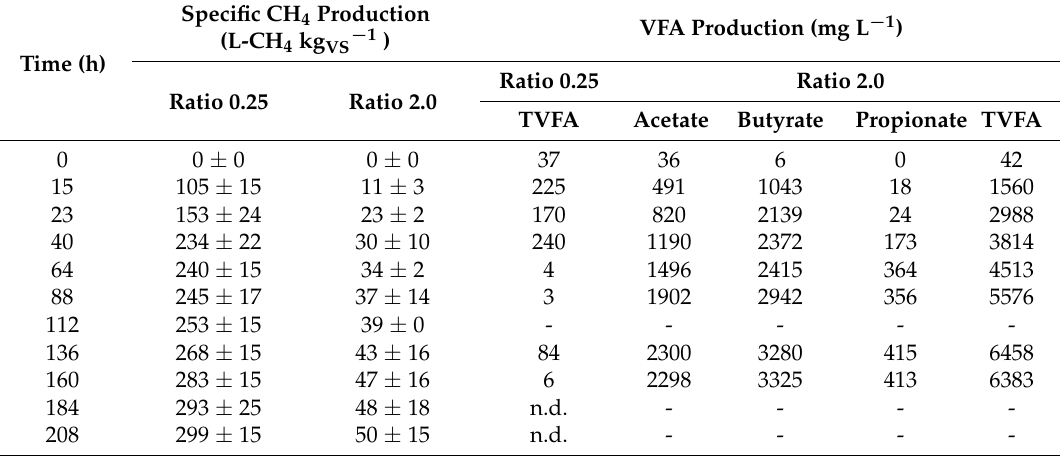
Results obtained from batch digestion test under non-inhibitory and inhibitory conditions. Specific CH 4 production and total volatile fatty acid (TVFA) production for glucose biodegradability tests at the two ratios tested of volatile solids for substrate and inoculum (VS-substrate/VS-inoculum = 0.25 and 2). Production profiles of acetate, butyrate, and propionate are presented for the VS substrate/inoculum ratio of 2 (n.d. = no detected; - = no data